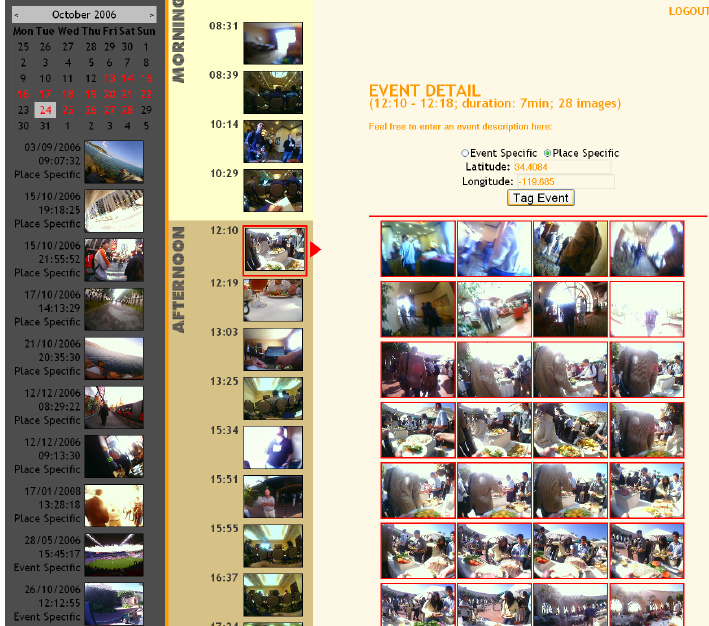
Figure 8. SenseCam browser to mark events for